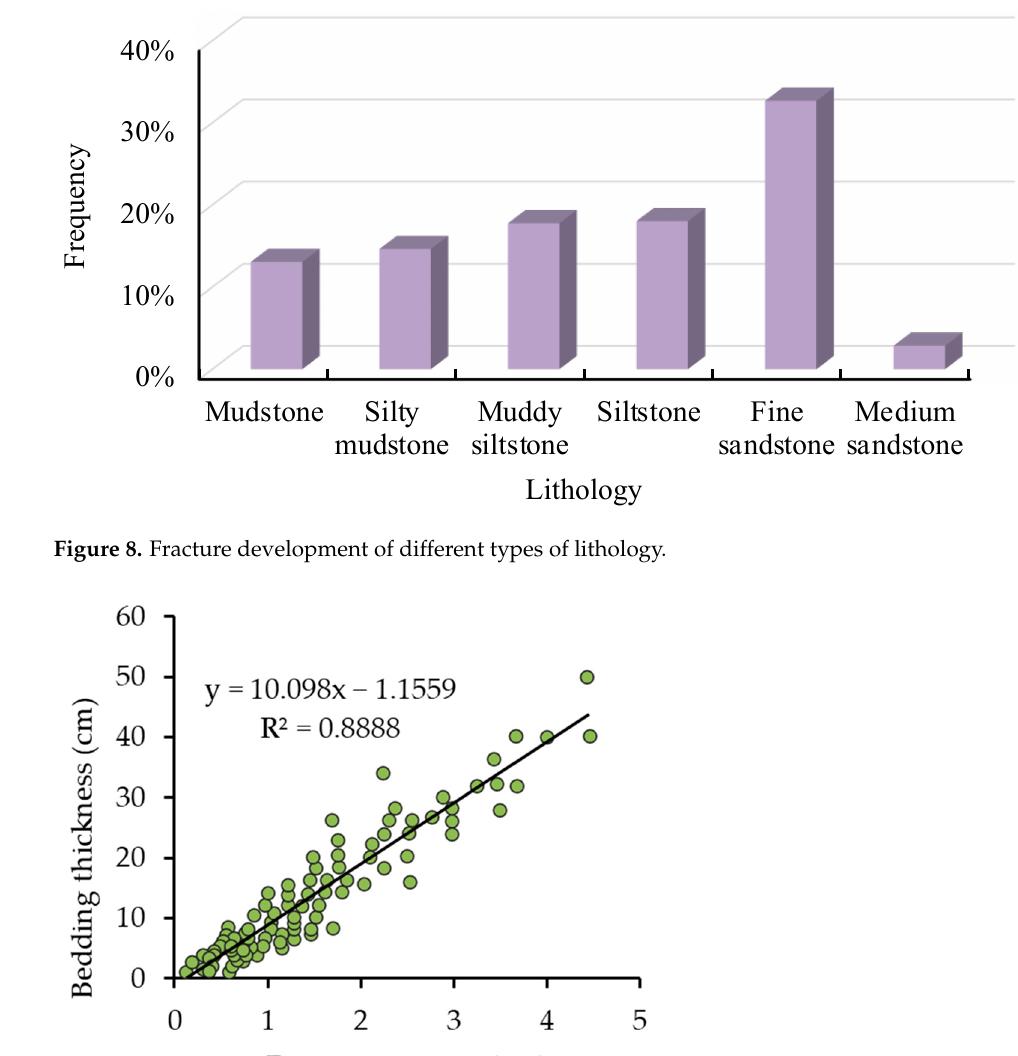
Figure 10. ( a ) Fracture identification effect of conventional logs in well Y298 (CAL, caliper; SP, spon- taneous potential; GR, gamma ray; AC, acoustic log; CNL, compensated neutron; DEN, density; RD, deep resistivity; RS, shallow resistivity; PERM, permeability; SW, water saturation; Sand, the con- tent of sandstone; Shale, the content of shale; CFI, composite fractures indicator), ( b – e ) Core photos, depth positions correspond to track 9 of ( a ).